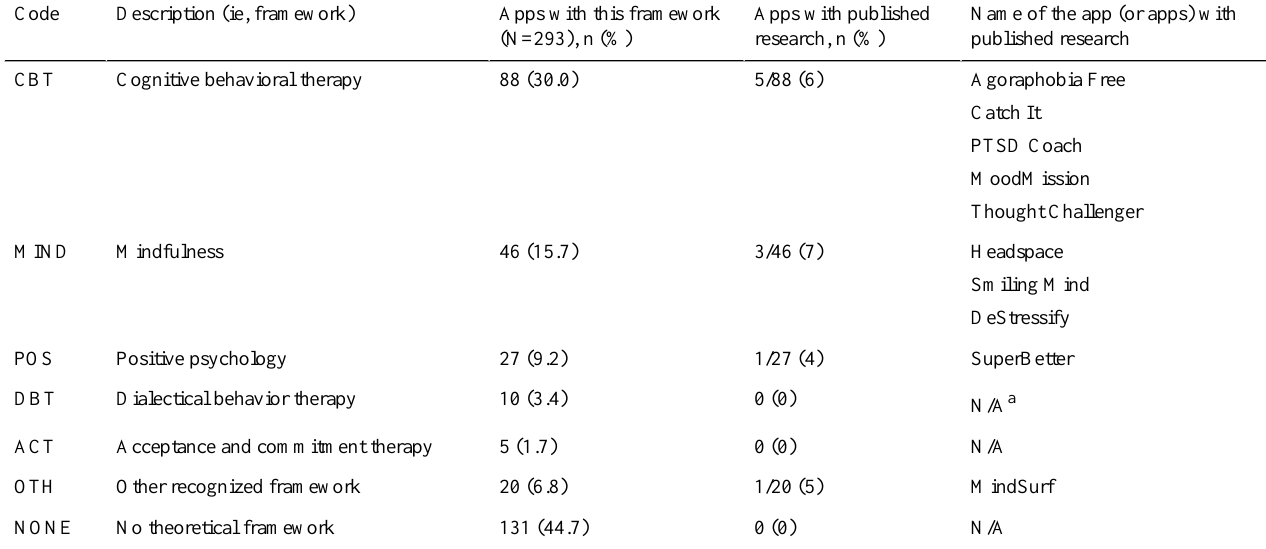
Table 1. Coding used for app store search, and the search results.